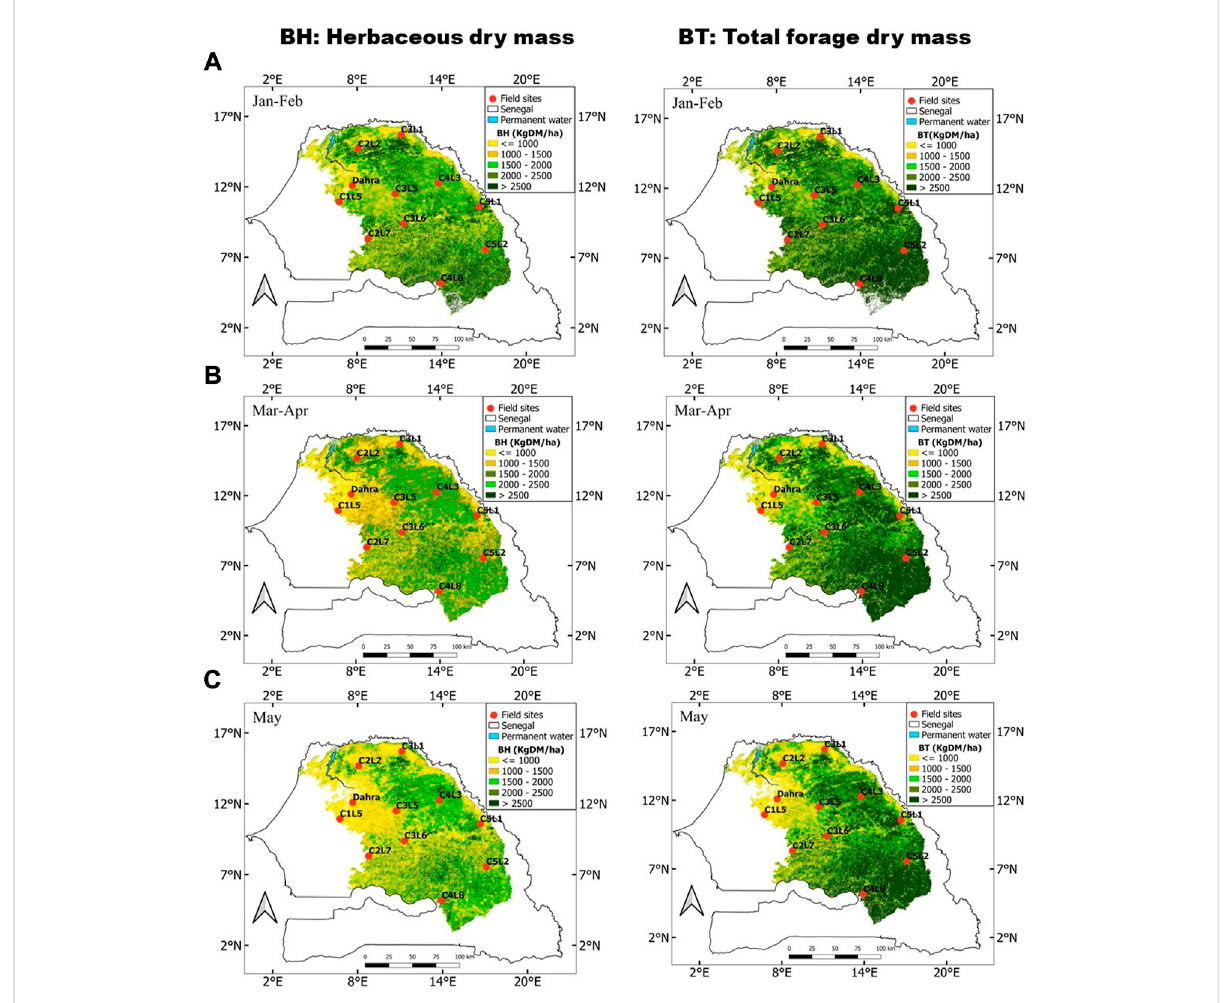
FIGURE 5 Predictionmapsofherbaceousdrymassandtotalforagedrymassin (A) January – February, (B) March – April,and (C) Maywiththebestmodelto estimate BH and BT.